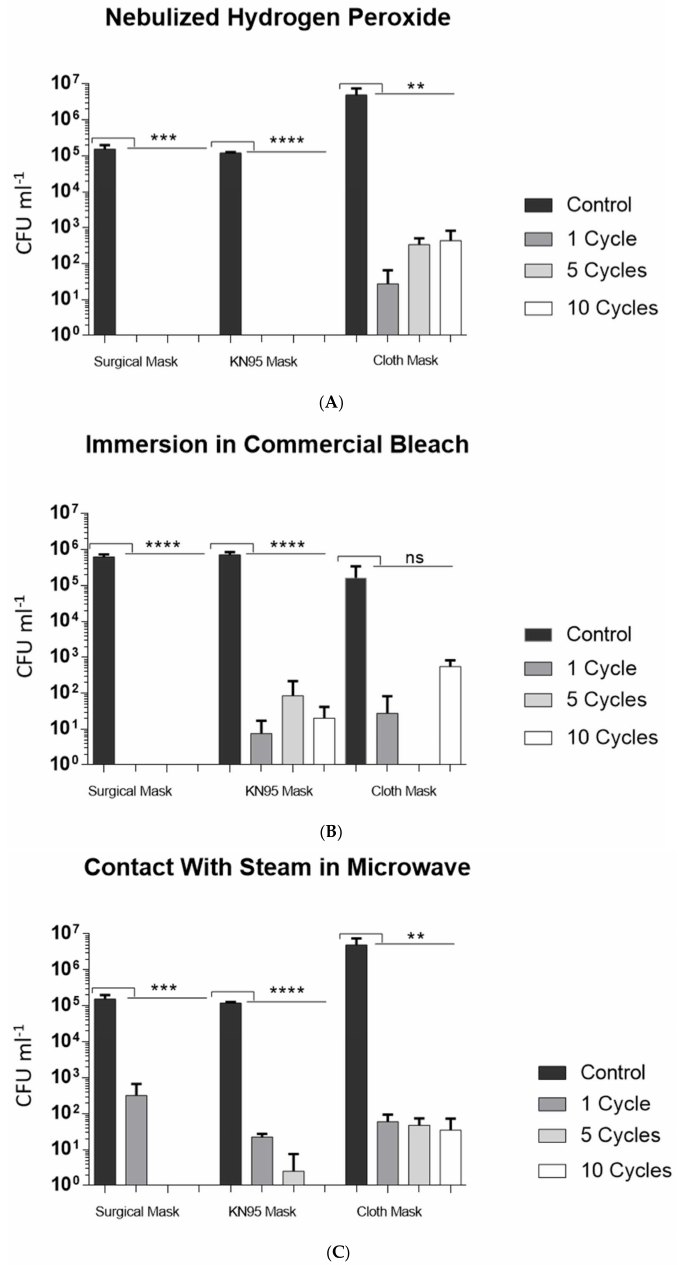
Figure 2. Decontamination of three types of RPD using different procedures: nebulized hydrogen peroxide ( A ), immersion in commercial bleach ( B ) and contact with microwave-generated steam ( C ). Surgical, KN95 and cloth masks were inoculated with indicator endospore suspension with approximately 107 endospores mL − 1 . After the treatment cycles (1c, 5c and 10c), the endospores survival was evaluated by plating assay. Untreated RPD were included as controls in all assays. Data shown are the mean values ( ± standard deviation) obtained from three or four replicates. The type of mask (surgical, KN95 and cloth masks) is presented in the X-axis of the three plots. Ns—not significantly different, **, ***, **** signal a statistically significant difference from the control, at significance levels of 0.01, 0.001 and 0.0001,